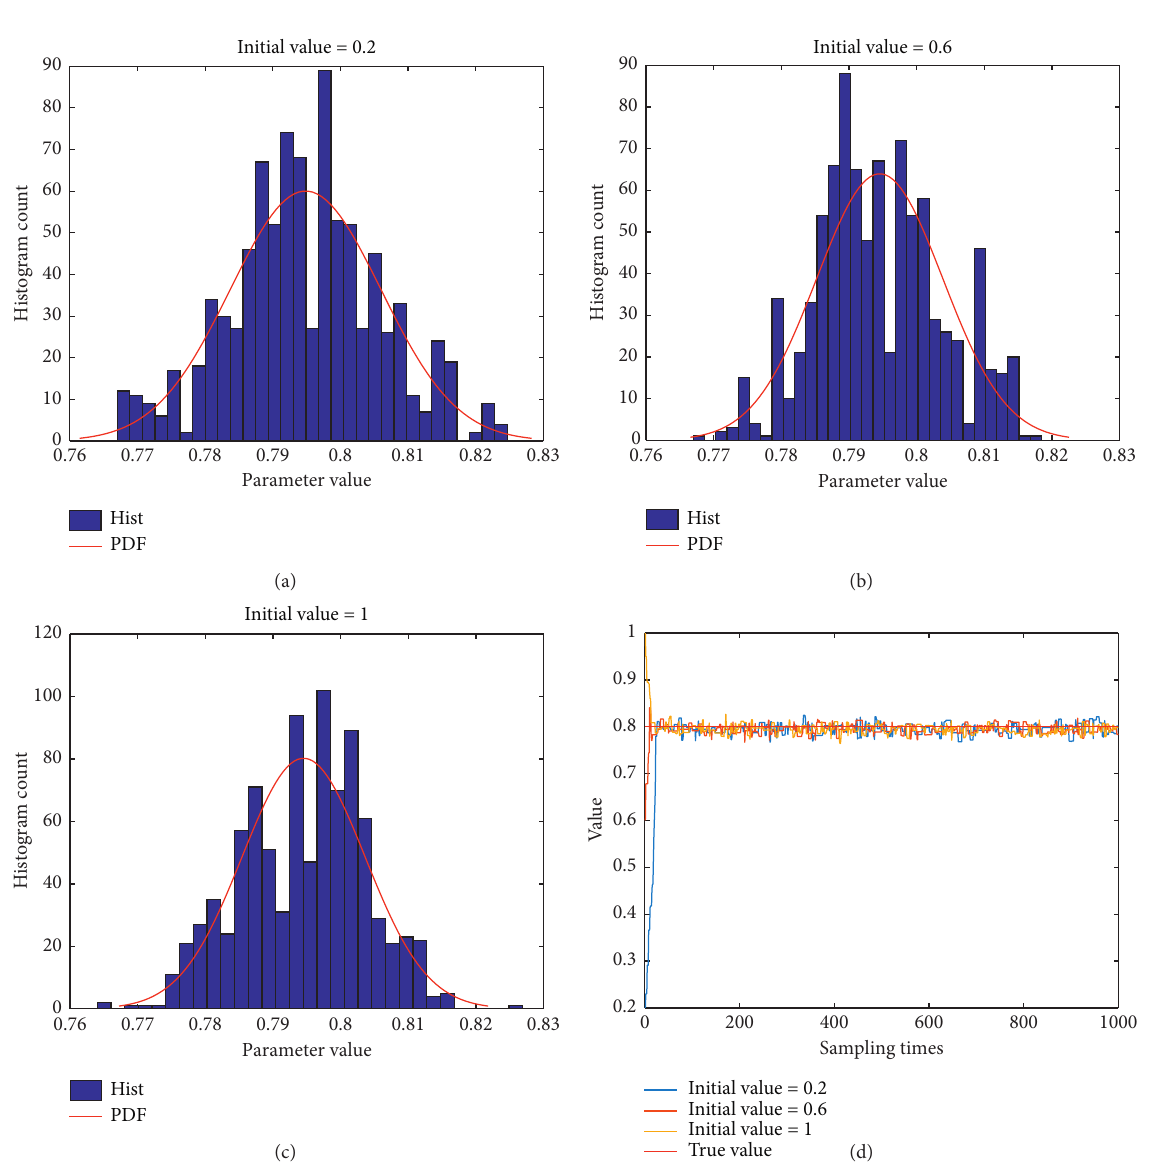
Figure 3: Influence of initial value: (a) initial value � 0.2, (b) initial value � 0.6, (c) initial value � 1, and (d) sampling